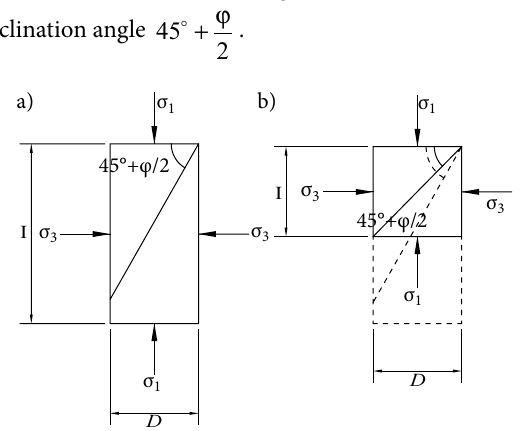
Fig. 1. Failure schemes of sand sample: a – ratio of H/D =